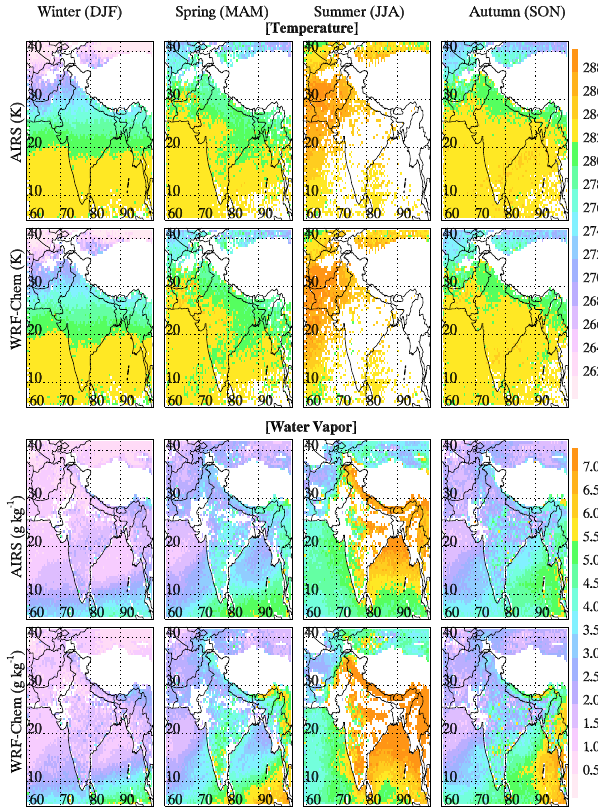
Fig. 4. Spatial distribution of co-located AIRS retrieved and simu- lated average temperature (first and second rows) and water vapor (third and fourth rows) at 700hPa during the winter (DJF), spring (MAM), summer (JJA) and autumn (SON) seasons of the year 2008. The white space indicates missing